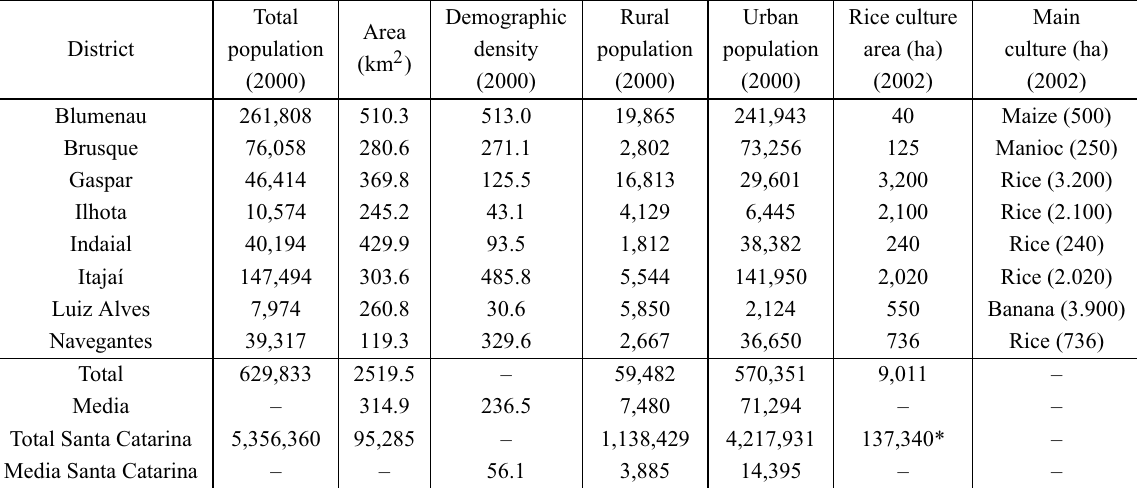
Socio-economic indicators for the municipal districts of the region around the Itajaí estuary.